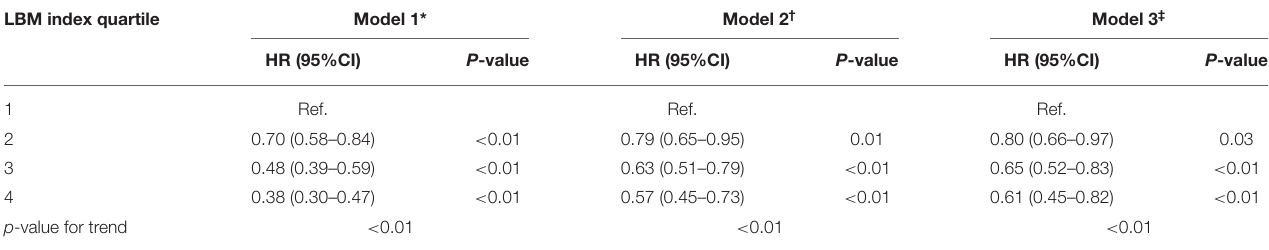
TABLE 2 | Hazard ratios (HR) for 1-year mortality of HF patients by lean body mass (LBM) index quartiles. LBM index